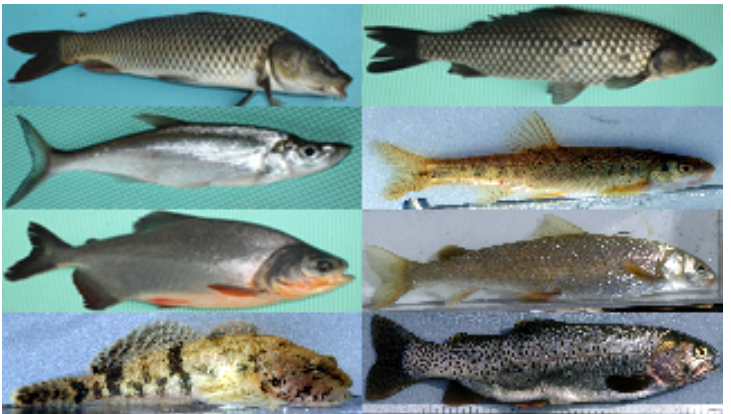
Figure 8. Examples from the BYU Fish dataset. The images in this dataset are 161 × 46 of eight different fish